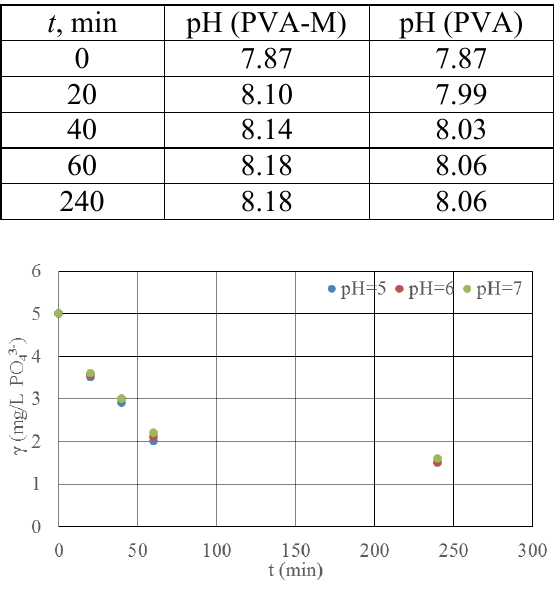
Figure 5. Phosphate concentrations